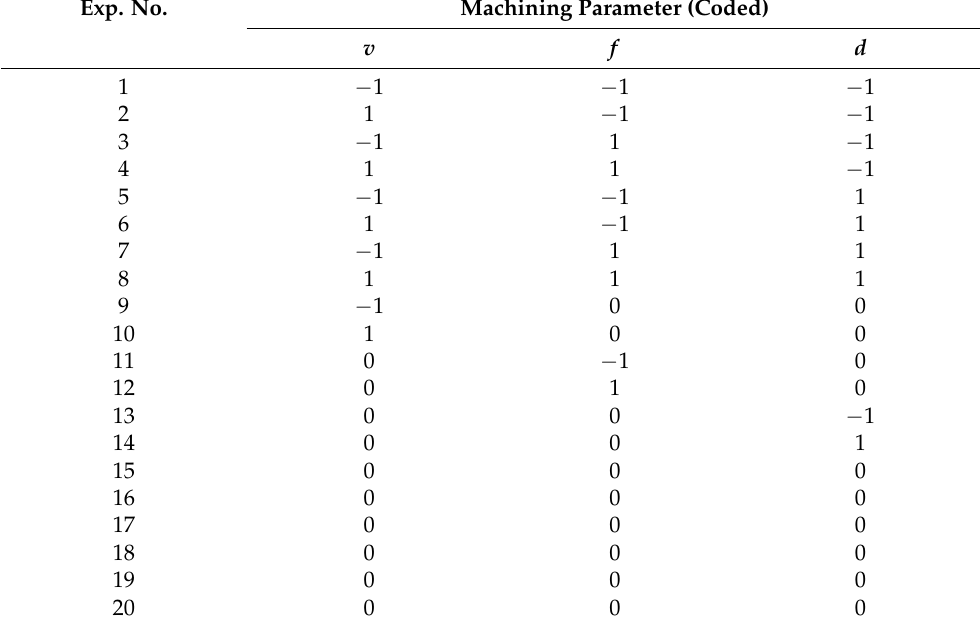
Table 2. Experimental matrix obtained from RSM-based FCCCD design. Exp. No.